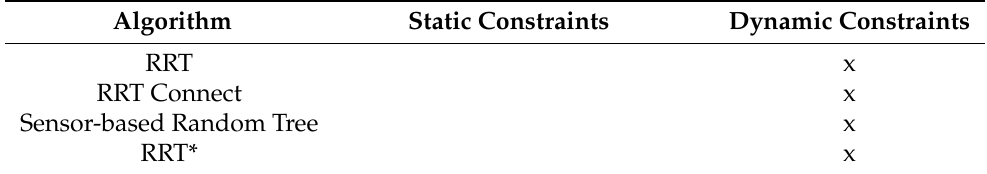
Table 5. Classification of the RRT algorithm and its variants based on static and dynamic